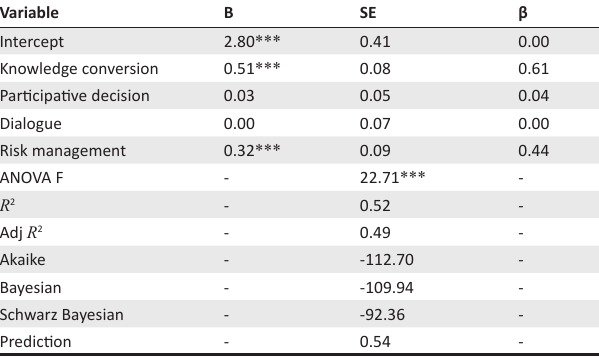
TABLE 4: Linear regression results for the effect of risk management on social innovation (Hypnotises 3).